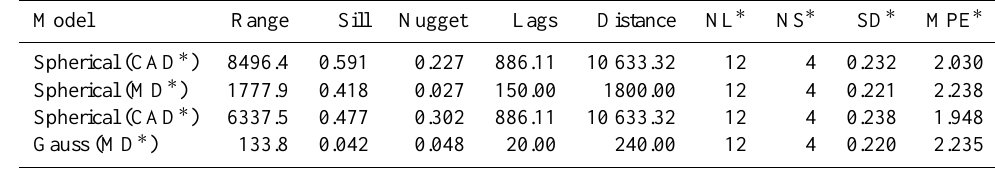
Table 3. Comparison of manually and automatically determined parameters of the interpolation method (example for OCK). Model